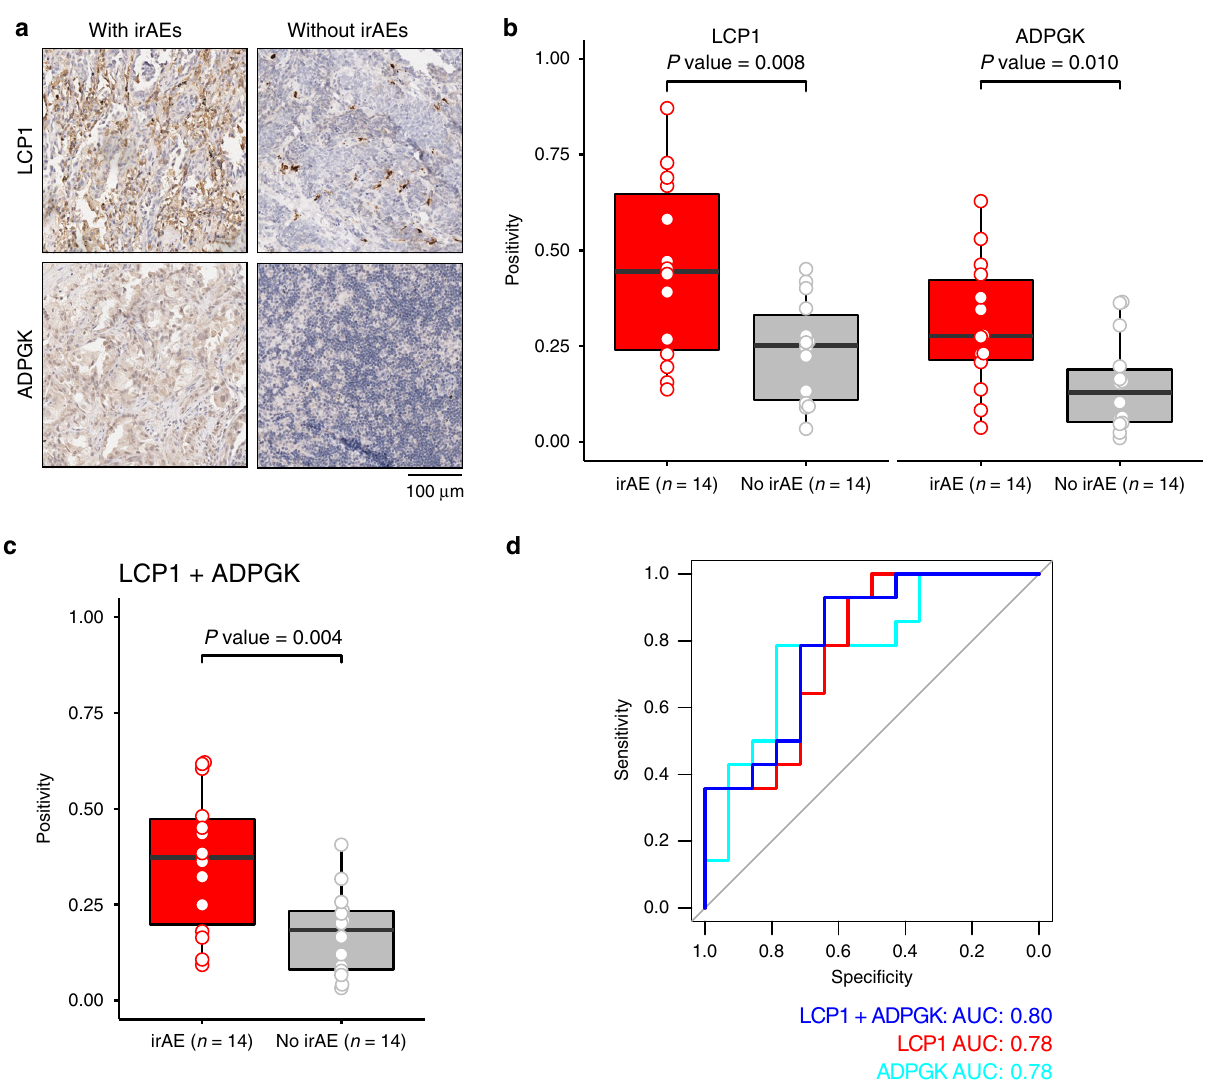
Fig. 3 Validation of the predictive power of LCP1 and ADPGK in a patient cohort. a Representative images of patients with irAEs and without irAEs through immunohistochemical (IHC) staining with antibodies against ADPGK and LCP1. Image size: 379 × 379 μ m 2 ; scale bar: 100 μ m. b Quanti fi cation of LCP1 and ADPGK IHC staining signals. Comparison between patients with irAE or without irAE is conducted by unpaired two-sided Student ’ s t test. c Geometric mean of LCP1 and ADPGK staining signals. A comparison between patients with irAE and without irAE is conducted by unpaired two-sided Student ’ s t test. d ROC curve of the LCP1, ADPGK, LCP1 + ADPGK in the validation cohort ( n = 28). The boxes indicate the median ± 1 quartile, with whiskers extending from the hinge to the smallest or largest value within 1.5 interquartile range from the box boundaries. ROC receiver-operating characteristic, AUC area under the receiver-operating characteristic